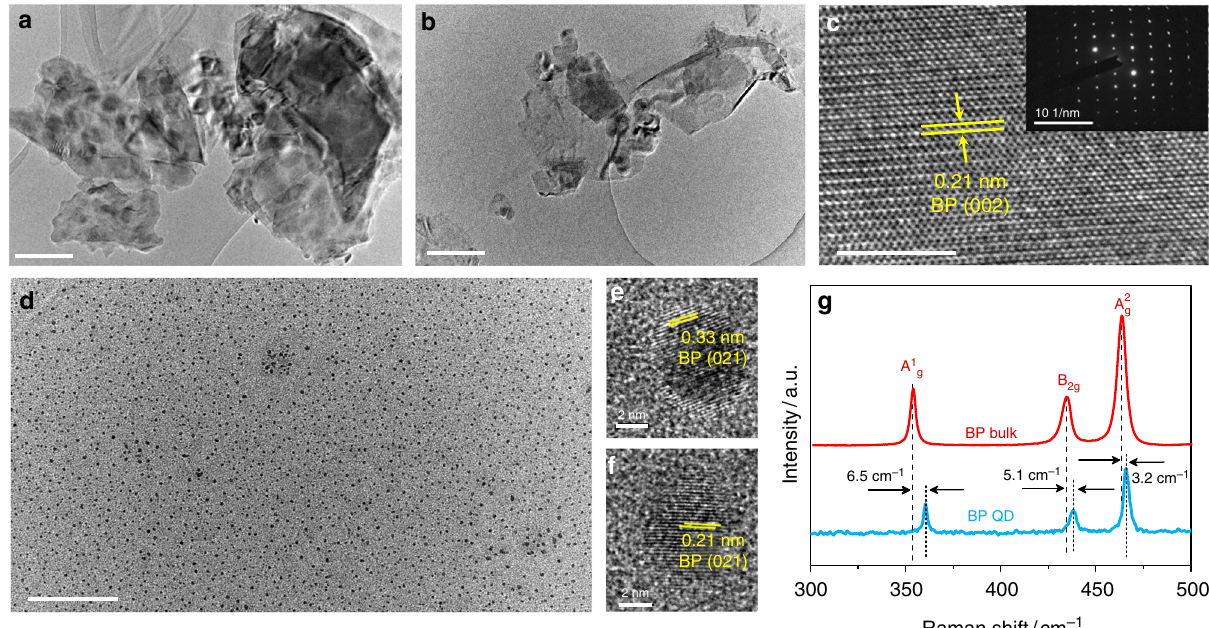
Fig. 1 Morphological and structural characterization of the black phosphorus fl akes. a Transmission electron microscopy (TEM) image of black phosphorus (BP) that was centrifuged at 4000 rpm (BP-4 K), b TEM image of BP centrifuged at 8000 rpm (BP-8K), c high-resolution TEM (HRTEM) image and corresponding selected area electron diffraction (SAED) pattern (inset) of BP-8K, d – f TEM and HRTEM images of black phosphorus quantum dots (BPQDs) with monodispersion and high crystallinity, g Raman spectra of bulk BP (red) and BPQD (blue) on a silicon (Si) substrate. Scale bars, 200 nm ( a , b ); 5 nm ( c ); 10 nm − 1 inset ( c ); 100 nm ( d ); 2 nm ( e , f